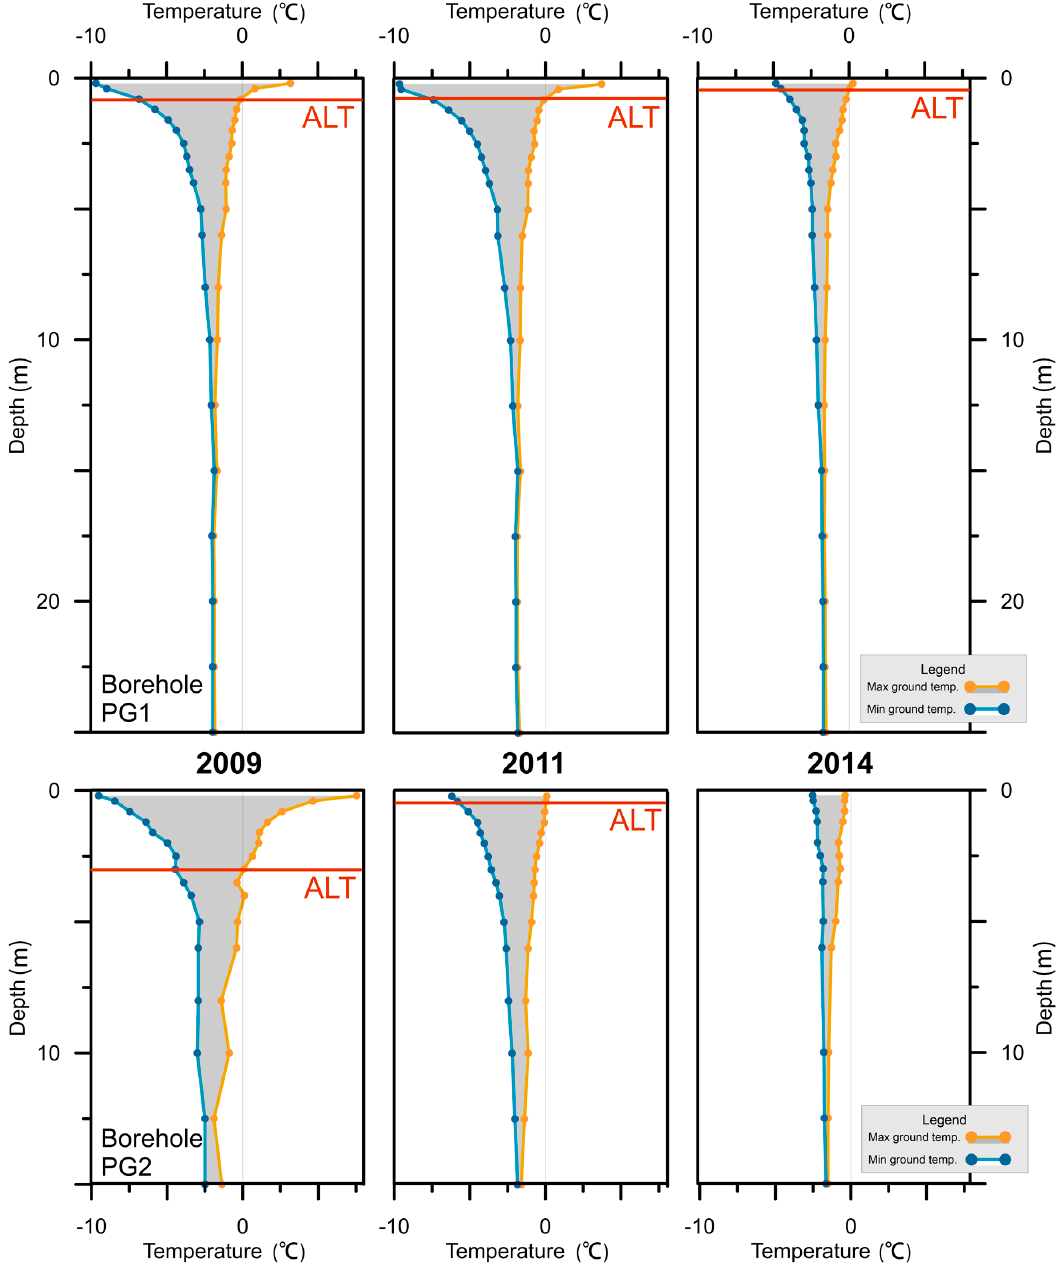
Figure 5. Maximum and minimum ground temperature and active layer thickness in PG1 and PG2 in three selected years (2009, 2011, and 2014). Table 4. Active layer thickness for boreholes PG1 and PG2 from 2009 to 2015.